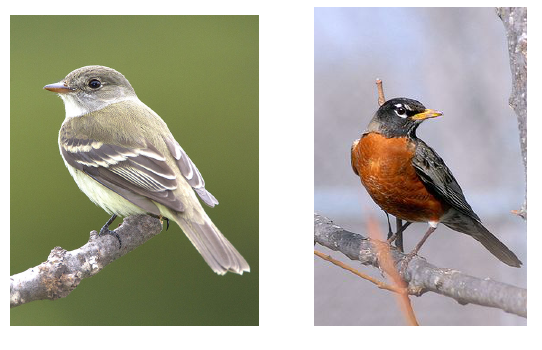
Figure 7: Alder Flycatcher(left) and American Robin(right)